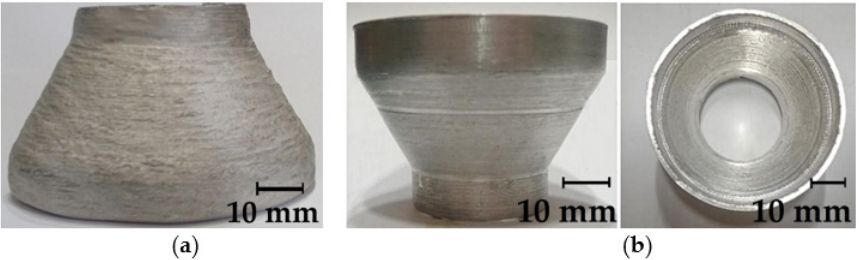
Figure 20. Nozzle with AlMg5Mn1Ti wire in WAAM: before ( a ) and after ( b ) machining. Nozzle diameter is 35–60 mm, specimen thickness before machining is 5 mm. WAAM with the addition of 1.6 wt.% SF 6 into argon.